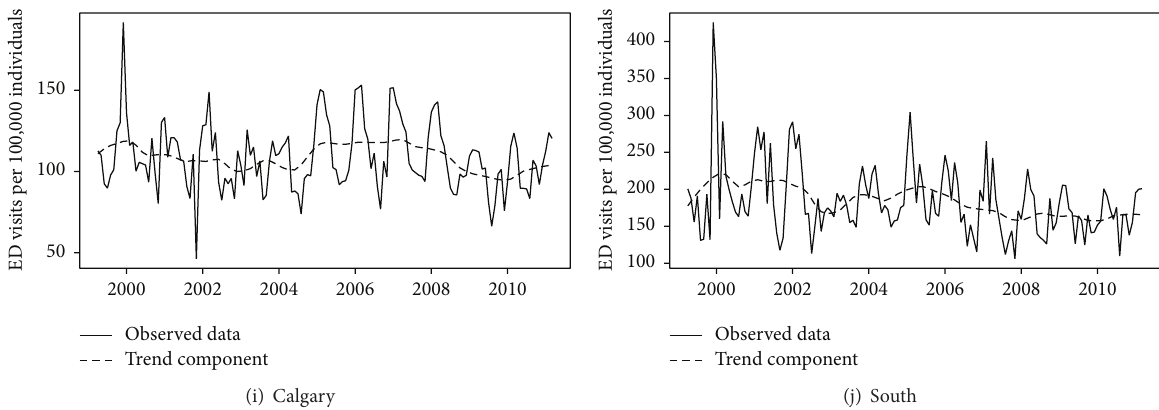
Figure 2: Monthly COPD ED visits per 100,000 individuals, April, 1999, to March, 2011, with overlay of trend component.